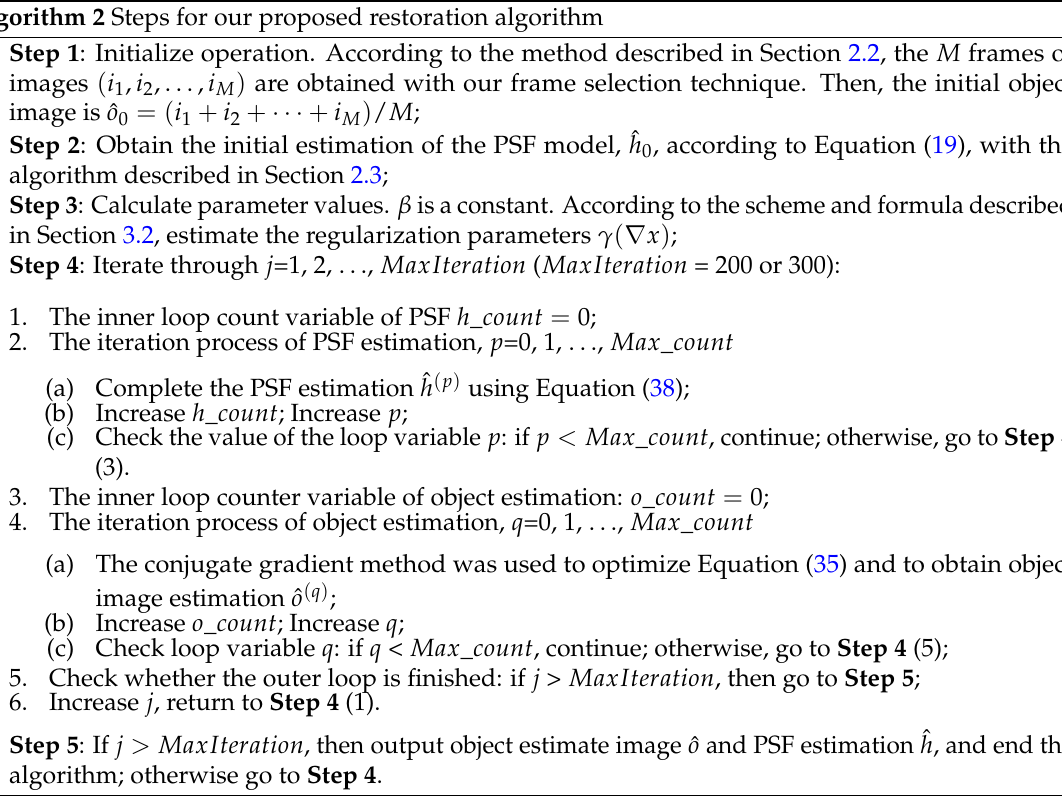
Algorithm 2 Steps for our proposed restoration